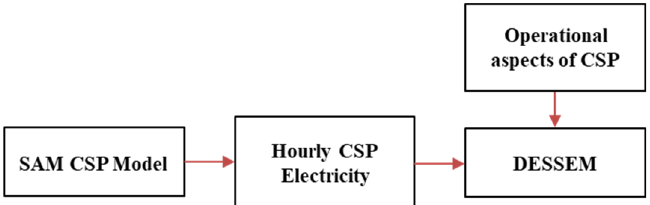
Figure 4. Process of implementing CSP. Adapted from [11].